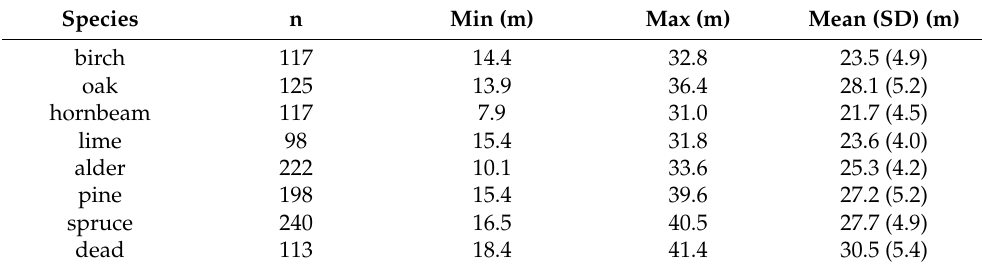
Table 2. Number (n) of selected reference trees divided into particular species. Additionally, informa- tion about the minimum (Min), maximum (Max), and mean (with standard deviation (SD)) height of trees in each class is